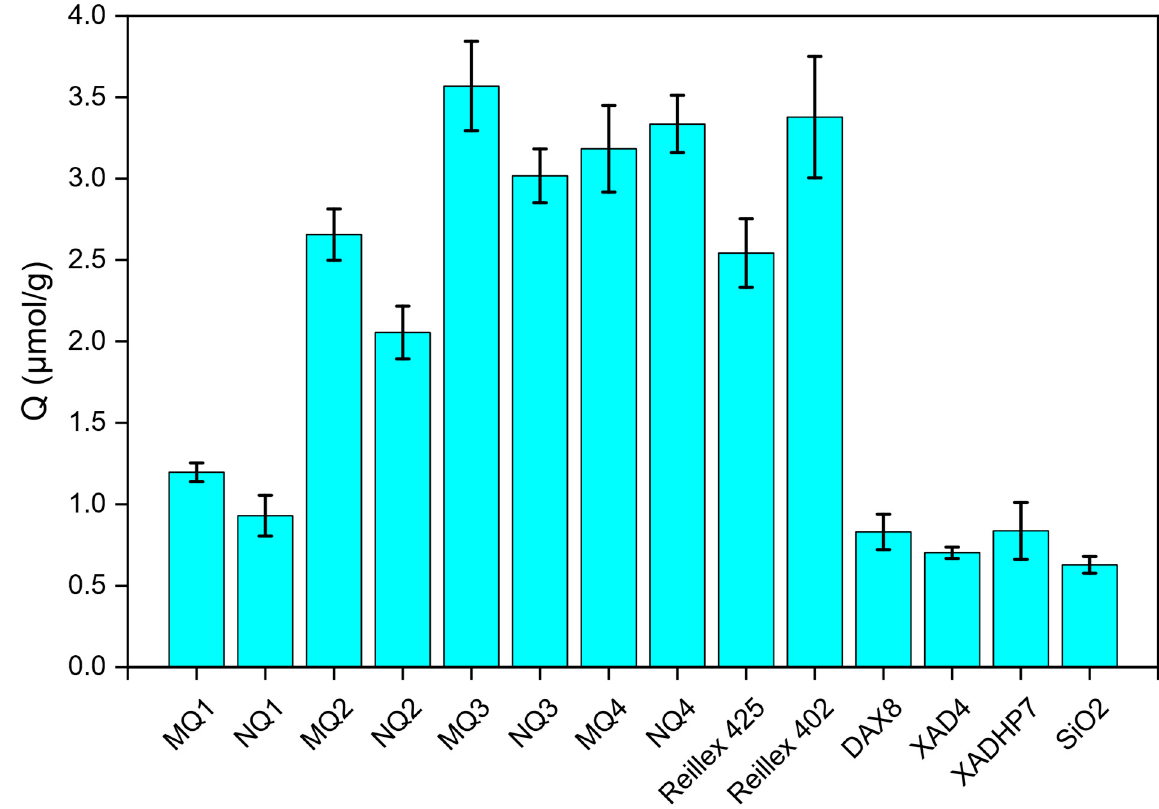
Figure 4. Batch sorption results in 8/2 EtOH/Water using 0.2 mM of